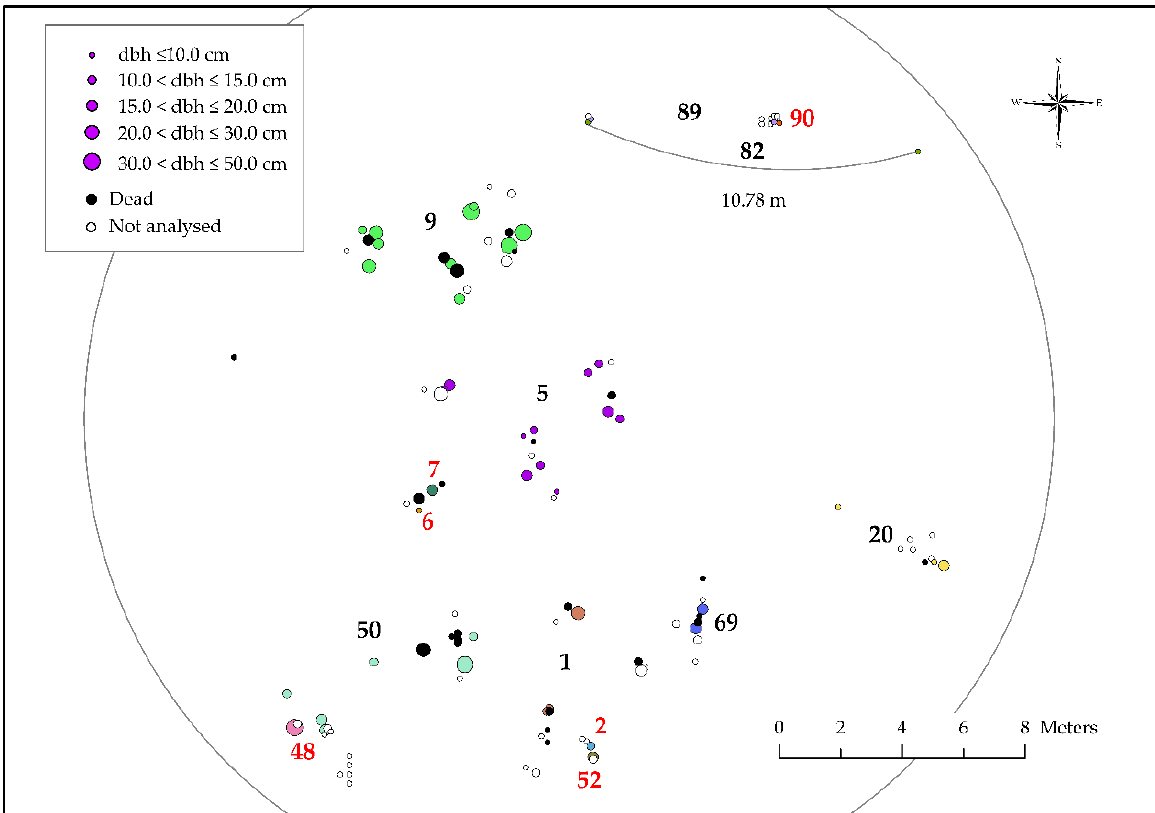
Figure 2. Clonal structure in plot A showing dead individuals (black), alive and not analyzed (white) and alive and analyzed (different colors for each MLG) and the dbh of each stem. Unique genotypes are numbered in red color.